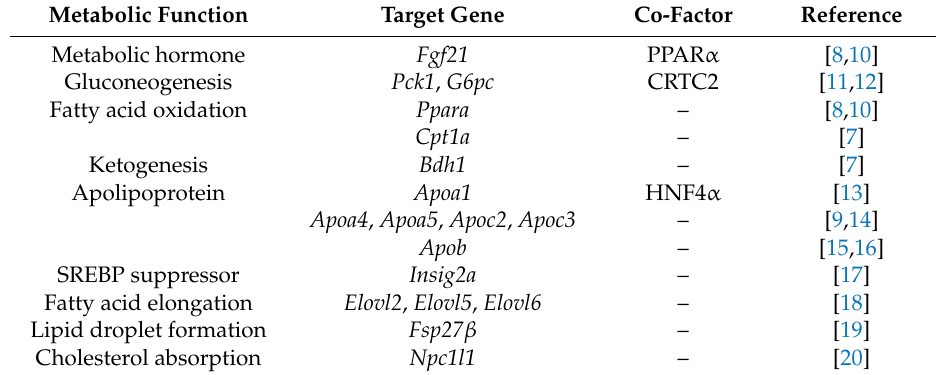
Table 1. The list of cAMP-responsive element-binding protein H (CREBH) direct target genes and mediating